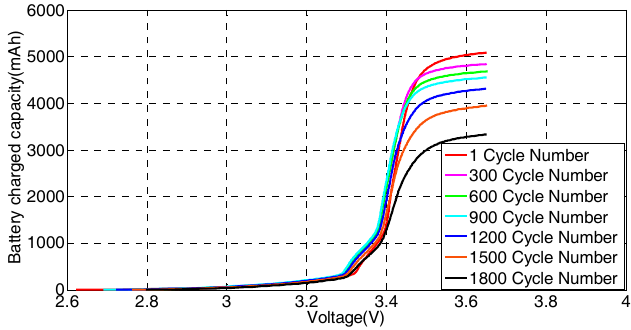
Figure 3. Battery charge capacity in different cycle numbers.